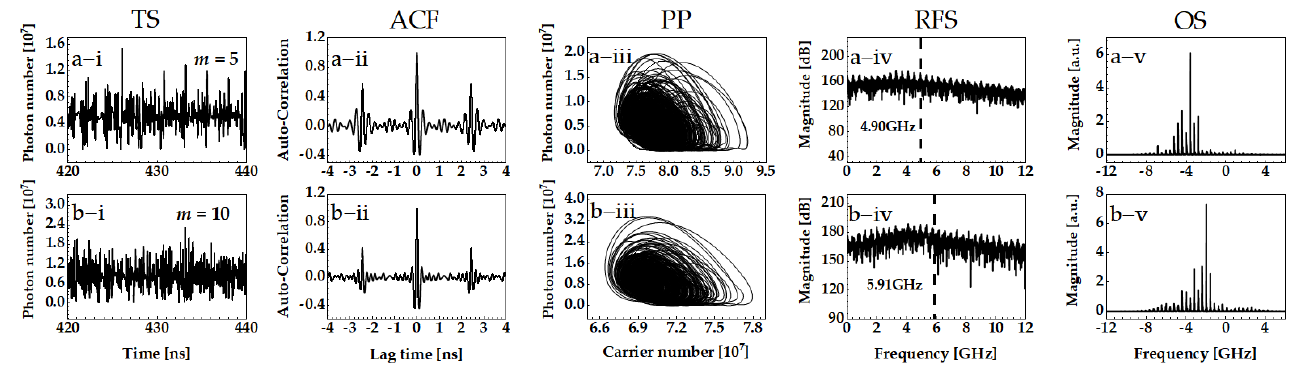
Figure 11. Output chaos of ICL with external optical feedback as stage number increases with I = 1.9 I th , τ f = 2.4 ns and f ext = 28%. ( a ) m = 5, ( b ) m = 10. Columns (i-v) are TS, ACF, PP, RFS, OS, respectively.